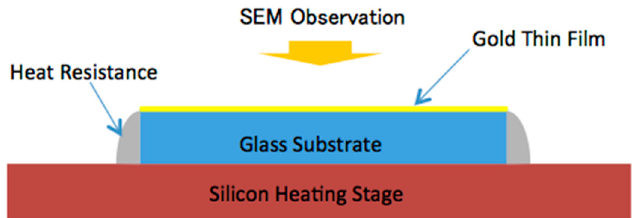
Figure 4. The schematic diagram for a substrate during the silicon heating stage. SEM: scanning electron microscopy.